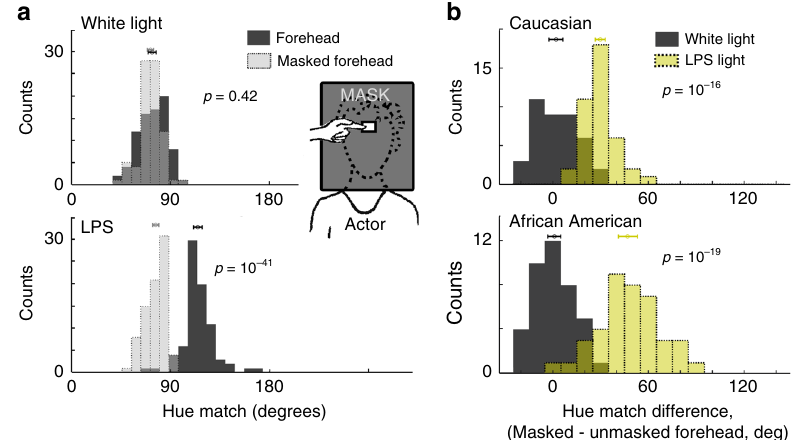
Fig. 5 Paradoxical color matches for face skin depends on face-shape information and is not race-dependent. a Histograms showing the angle of the color matches for forehead and masked forehead under white light (top) and low-pressure sodium light (bottom) ( N = 20 participants; matches made to four actors: two Caucasian, two African American). Color matches in the masked condition were made by holding a sheet of black cardboard in front of the actor ’ s face, with a 1.5 cm × 2 cm aperture over the forehead. Masking the face context did not change the hue match under white light ( p = 0.42) but had a large impact on the color match under LPS light ( p = 10 − 41 ; p- values obtained by t -test not assuming equal variance; markers show average values, and error bars are 99% C.I.). b Histograms showing the difference in hue angle for color matches to forehead versus masked forehead, under white light versus LPS light, for Caucasian skin (top) and African American skin (bottom). The two distributions for each race do not have the same mean (Caucasian p = 10 − 16 ; African American p = 10 − 19 ; markers and error bars as for panel a ). Source data are provided as a Source Data fi